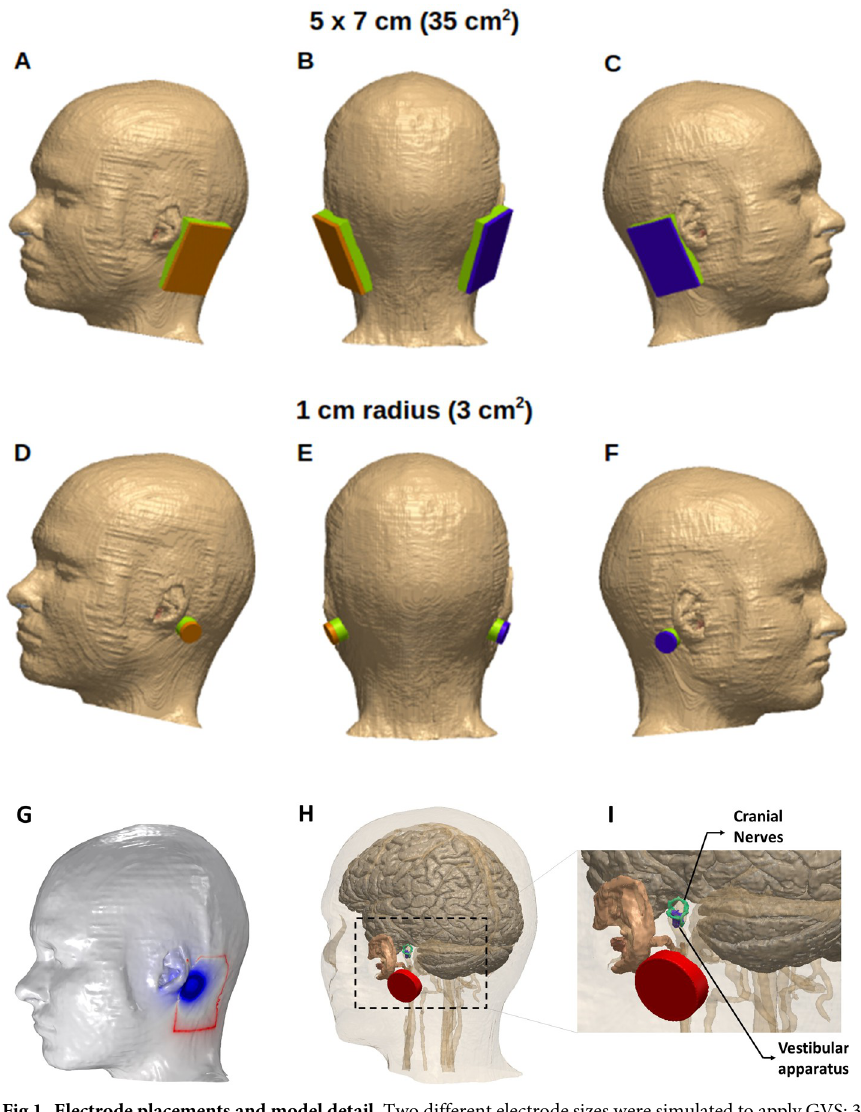
Fig 1. Electrode placements and model detail. Two different electrode sizes were simulated to apply GVS: 35 cm 2 (A-C) and ~3 cm 2 (D-F). The electrodes were placed on the skin-tissue mask in a Bilateral-Bipolar configuration. (G): The two electrode sizes were overlaid on the same head model geometry to highlight final placement with respect to the anatomy. (H): To highlight the region of interest in the model geometry with respect to other tissues and the stimulation electrode, certain tissue masks were made semi-transparent. (I): The dashed section in (H) is expanded to further highlight model detail.